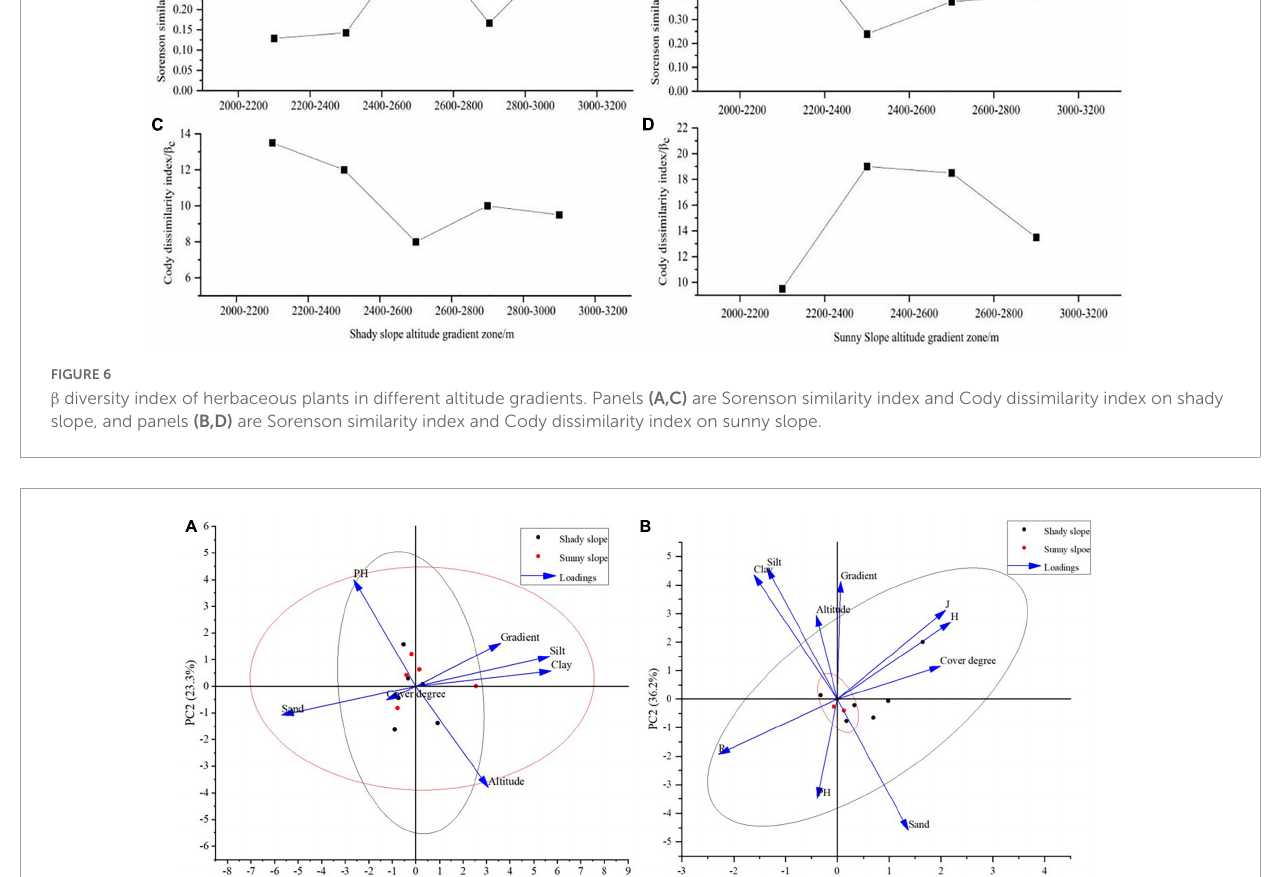
The Sejila Mountain on the Qinghai-Tibet Plateau is a region